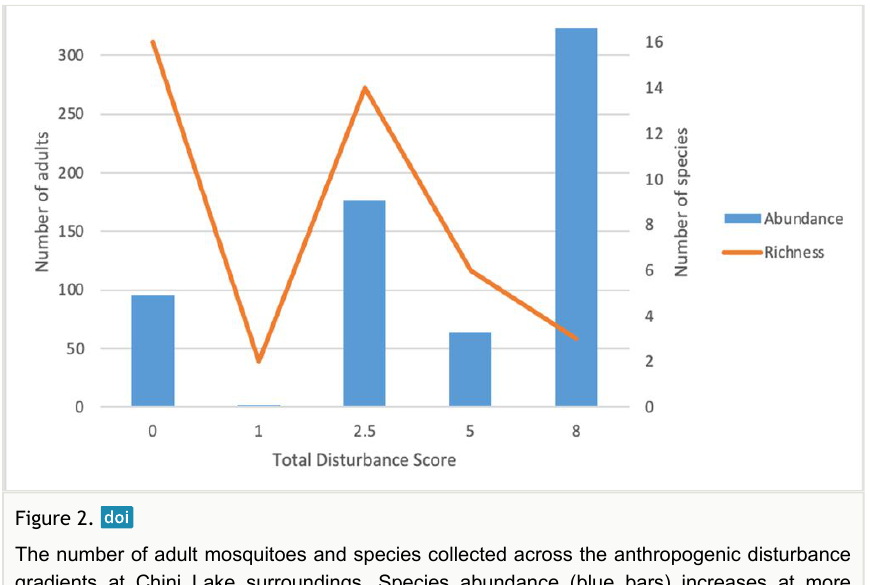
highest number of species collected. An exception is seen at the floating island (disturbance score = 1), most likely due to the absence of large mammals at this sampling